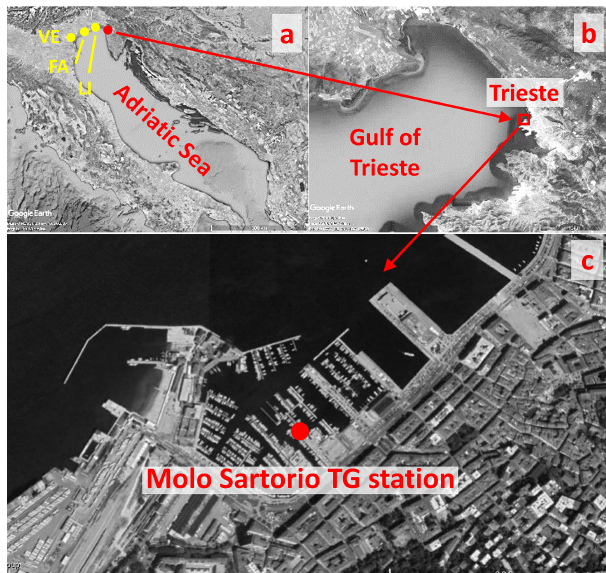
Figure 1. (a) The Adriatic region. (b) The Gulf of Trieste. (c) Aerial image of Trieste harbour with the location of the tide-gauge (TG) station. The yellow dots in panel (a) indicate the stations of Venice Punta Salute (VE), Falconera (FA), and Porto Lignano (LI). (Im- ages extracted from © Google Earth, © 2020 Landsat/Copernicus, © 2020 CNES/Airbus, © 2020 Digital Globe, and © 2020 Terra-